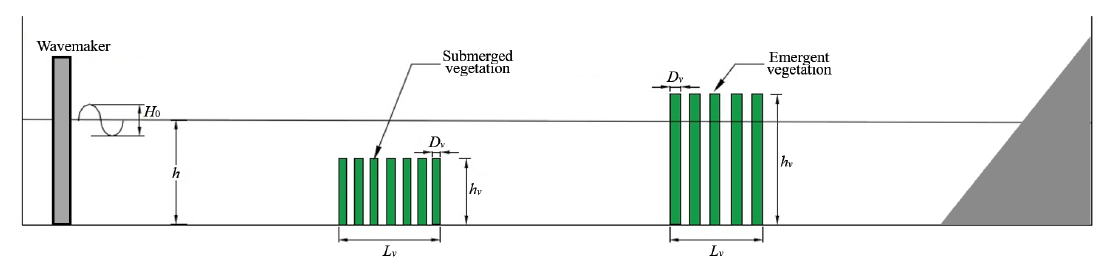
Figure 6. Typical experimental setup for the laboratory study on wave through a vegetated water with either submerged or emergent vegetation. H 0 : initial wave height; h : constant water depth; h v : vegetation steam height; D v : stem diameter; L v : width of the vegetated bed. A typical wave absorbing beach is usually installed at the end of the wave tank.